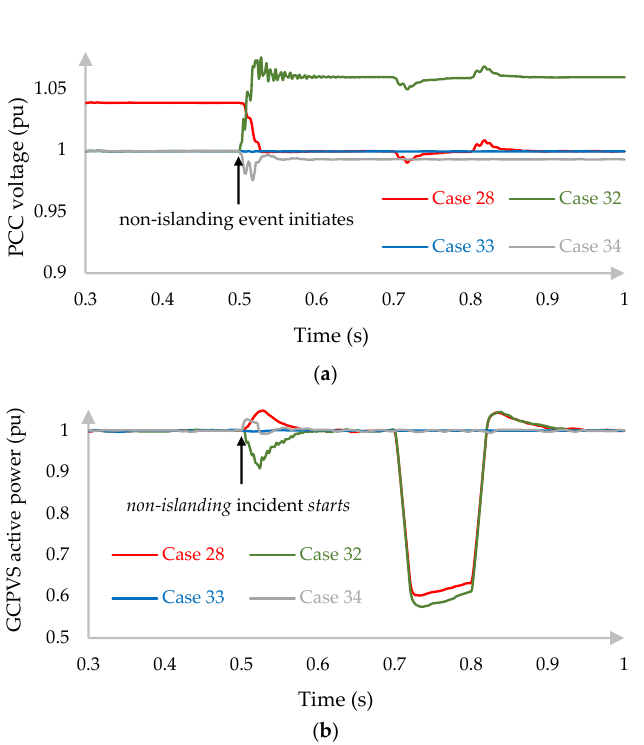
Figure 10. Outputs of non-islanding study: ( a ) PCC voltage, ( b ) First/Second GCPVS active power.